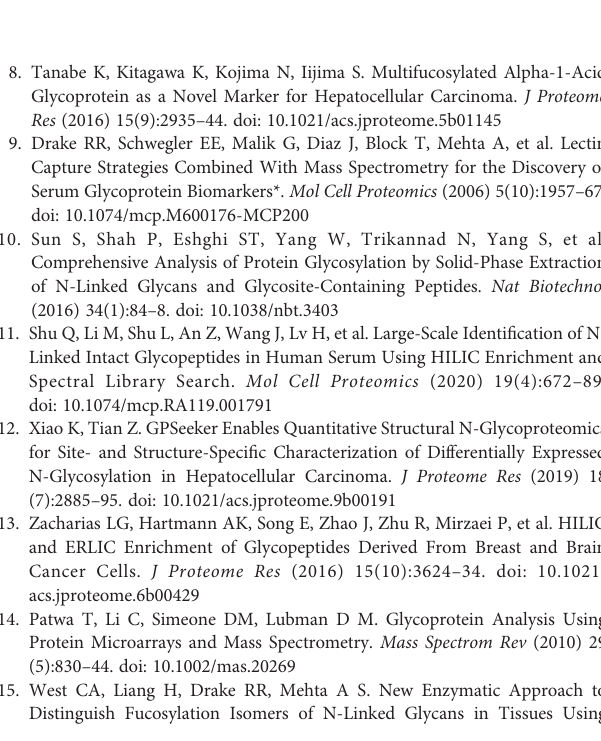
stage HCC serum samples (A – E) . Ratio offucosylated to non-fucosylated forms of these glycopeptides (F) and (G) . Supplementary Figure S2 | Representative MS/MS spectrum of N- glycopeptides of ELHHLQEQN 756 VSNAFLDK with the glycan HexNAc(5)Hex(6) NeuAc(3). The oxonium ions, glycosidic fragments and b/y fragments from the peptide backbone were well characterized. (The symbols used in the structural formulas: blue square = HexNAc; green circle = Man; yellow circle = Gal; purple diamond = NeuAc). Supplementary Figure S3 | Relative abundance of bi-, tri- and tetra-antennary glycopeptides EHEGAIYPDN 138 TTDFQR of ceruloplasmin in cirrhosis and early- stage HCC serum samples (A – G) . Ratio of fucosylated to non-fucosylated form of these glycopeptides (H, I) . Supplementary Figure S4 | Relative abundance of bi- and tri-antennary glycopeptides EN 397 LTAPGSDSAVFFEQGTTR of ceruloplasmin in cirrhosis and early-stage HCC serum samples (A – E) . Ratio of fucosylated to non-fucosylated forms of these glycopeptides (F – H) . Supplementary Figure S5 | Relative abundance of bi- and tri-antennary glycopeptidesAGLQAFFQVQECN 358 Kofceruloplasmin incirrhosisandearly-stage HCC serum samples (A, B). Supplementary Table S1 | PRM precursor ions list of ceruloplasmin. Supplementary Table S2 | Comparisons of the number of unfractionated and fractionated glycopeptides from pooled late-stage HCC samples. Supplementary Table S3 | Distribution of glycopeptides in different antennas, fucosylated and sialylated glycan numbers in cirrhosis. Supplementary Table S4 | Distribution of glycopeptides in different antennas, fucosylated and sialylated glycan numbers in early-stage HCC. Supplementary Table S5 | Distribution of glycopeptides in different antennas, fucosylated and sialylated glycan numbers in late-stage